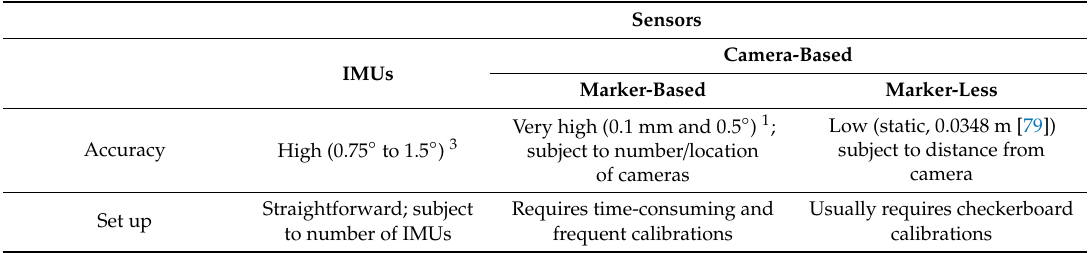
Table 4. Characteristics of the most used MoCap systems.